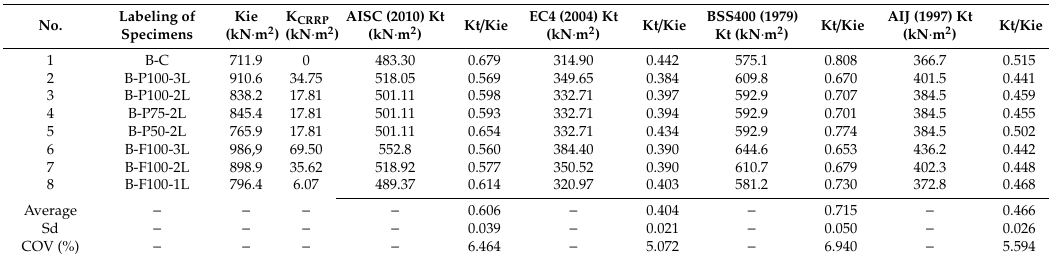
Table 7. The comparative result among predicted total flexural sti ff ness (K t ) and test results of K se . No. Labelingof